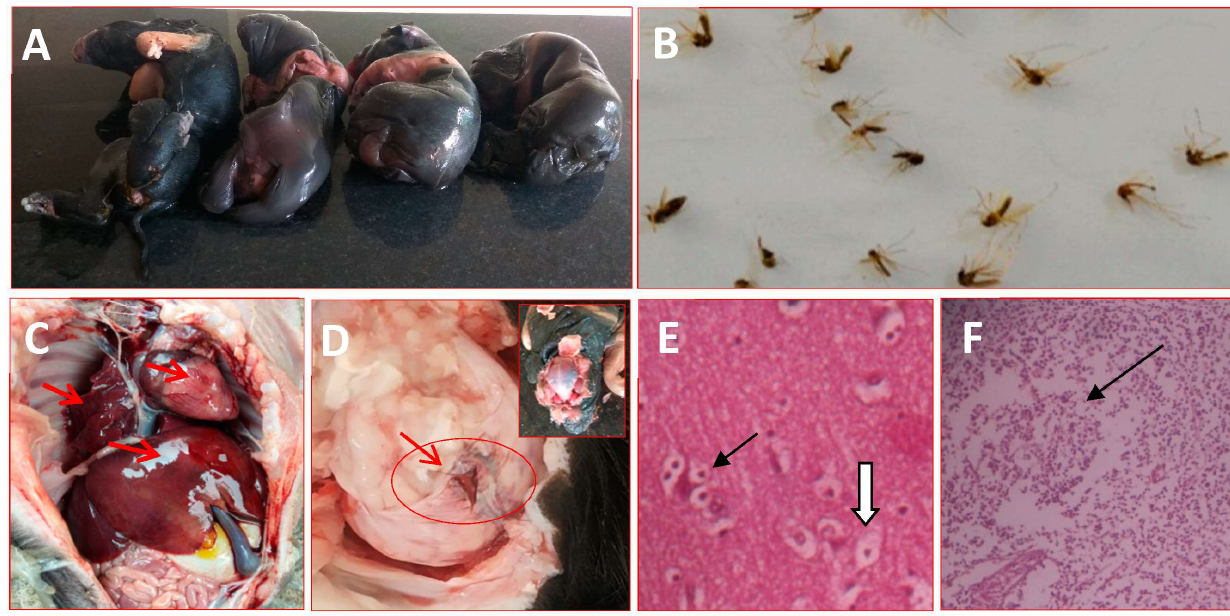
Figure 2. Japanese encephalitis (JE) case specimens of the current study. Here, ( A ) Stillborn fetuses in a sow due to JE infection during pregnancy, ( B ) A pool of Culex tritaeniorhynchus mosquito, a major vector of JEV transmission, ( C ) Congestion in the internal organs (arrow), ( D ) Encephalitis in the brain in a stillborn foetus affected with JE (arrow), ( E ) Neuropathology in the cerebrum of a JEV- infected stillborn piglet. Neuronophagia and satellites (arrow), neuronal vacuolation (arrowheads) hematoxylin and eosin stained, 20 × magnification. ( F ) Lymphoid depletion in the lymphoid follicle of lymph node (arrow) hematoxylin and eosin stained, 20 ×